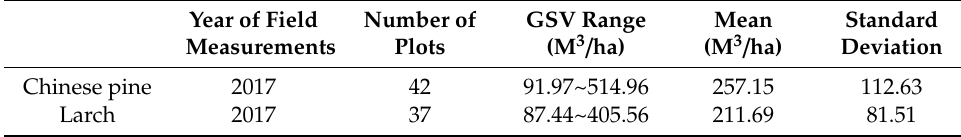
Table 2. The GSV statistics of sample